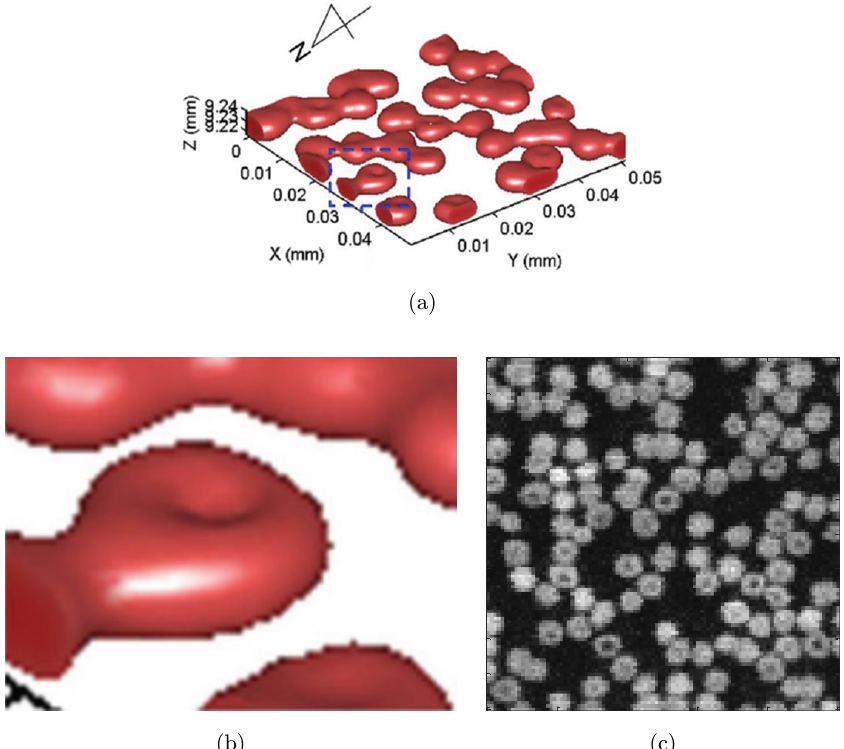
Fig. 8. (a) Three-dimensional photoacoustic image of an unstained human blood smear, (b) zoom-in of the dashed box in (a), and (c) maximum amplitude projection of the unstained human blood smear (images adapted from Ref. 68).